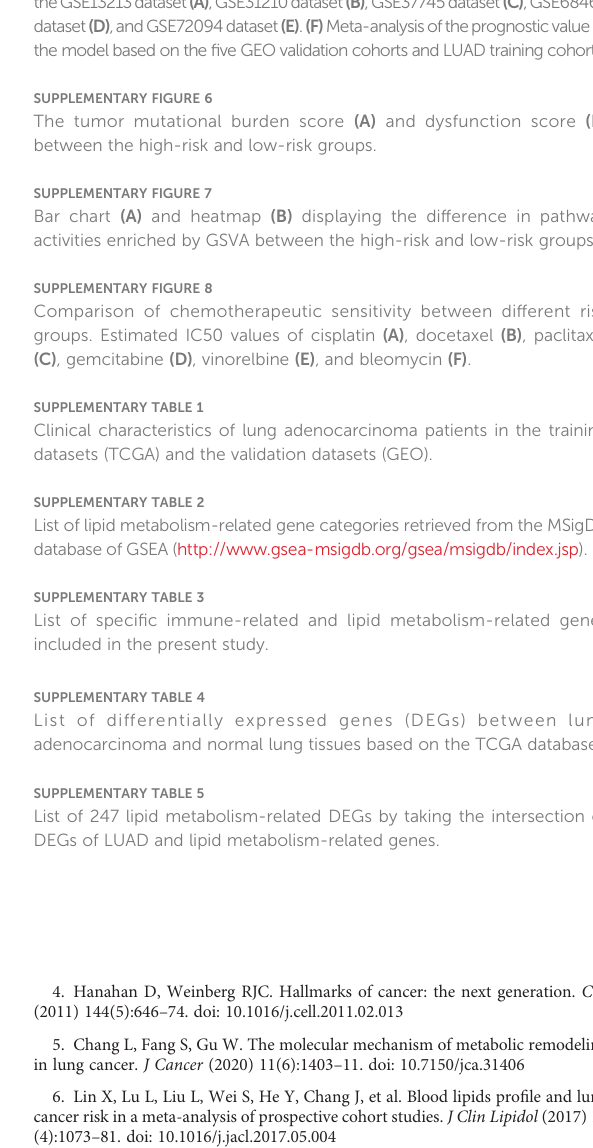
SUPPLEMENTARY FIGURE 1 The optimal number of clusters in the TCGA cohort was determined by the Silhouette index.